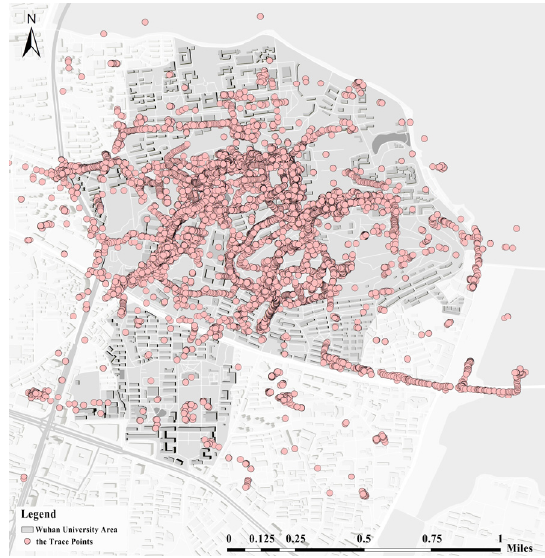
Figure 2. Trajectory points of